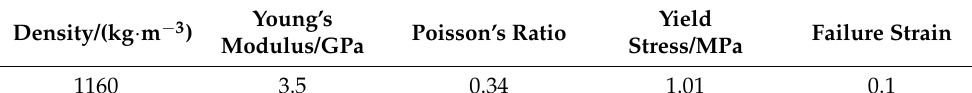
Figure 2. Schematic diagram of bi-linear elastic–plastic model.